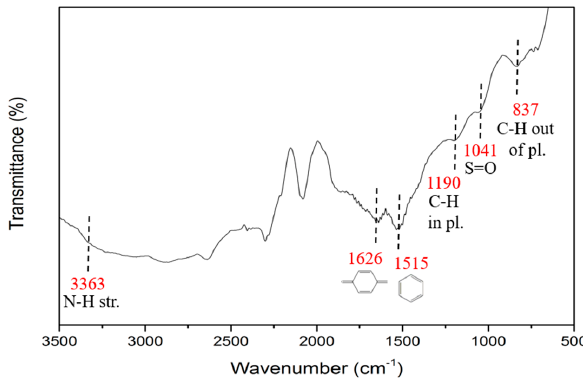
Figure 7. FTIR spectra of SPAN electrodeposited on mild steel with an AN/DABSA ratio of 8.8.